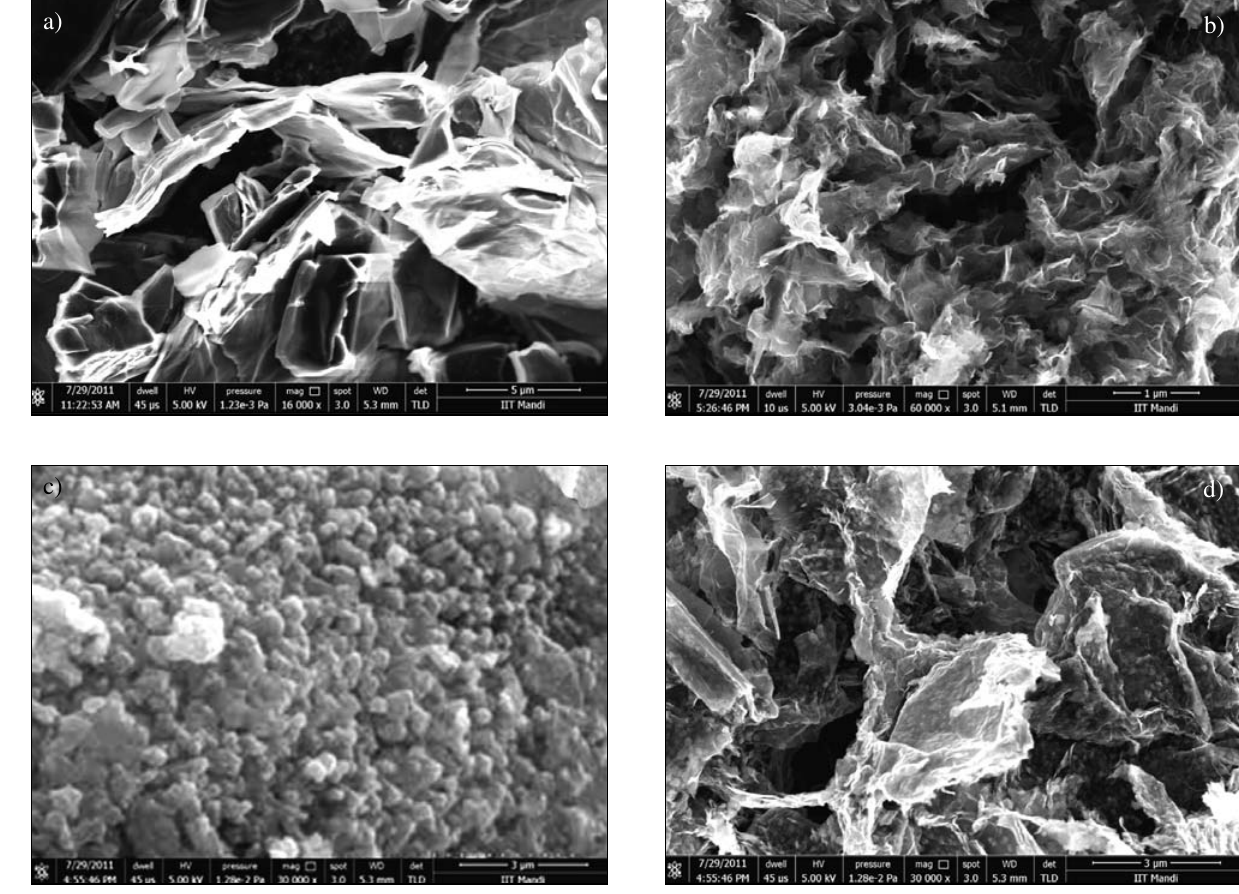
Figure 2. SEM images of (a) GO (b) NG (c) NiFe